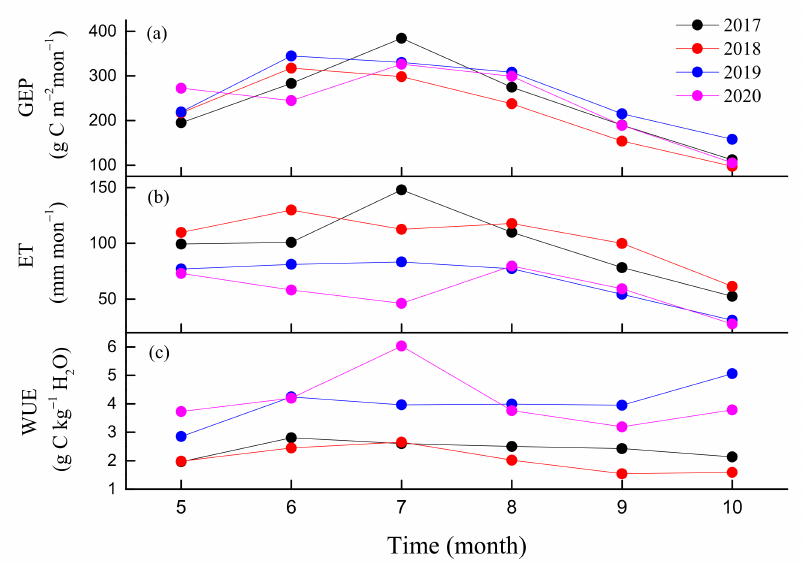
Figure 5. Seasonal dynamics of ( a ) monthly gross ecosystem production (GEP), ( b ) monthly evapo- transpiration (ET), and ( c ) monthly water use efficiency (WUE) during the growing seasons (May- October) from 2017 to